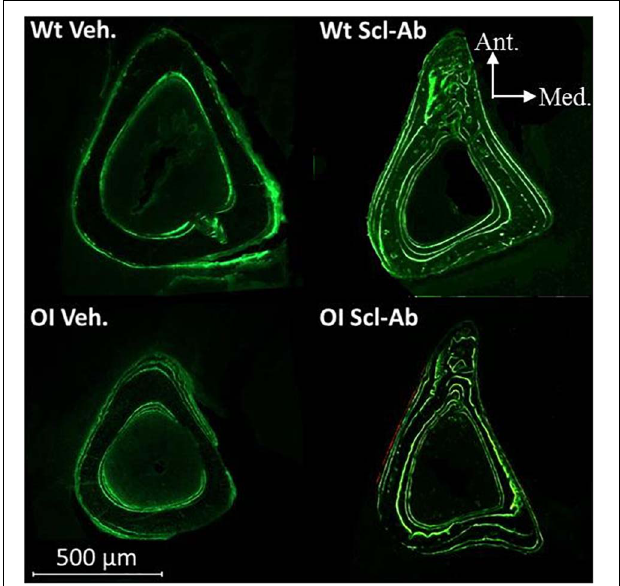
FIGURE 5 | Microradiograph of a cross section through the tibial shaft of male mice illustrating differences in bone mass and geometry between OI Veh. and Wt Veh. mice, as well as the effect of Scl-Ab on these characteristics in both groups.